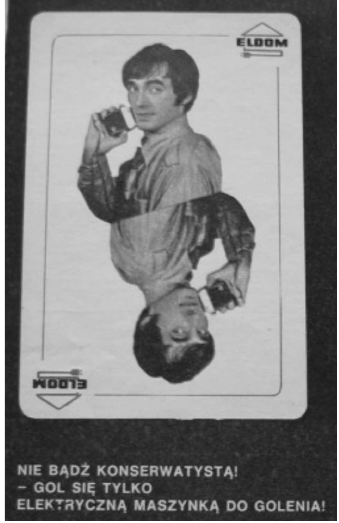
Figure 7. Example of commercial advertising in the PRL which reads: Don’t be a conservative – shave only with an electric razor